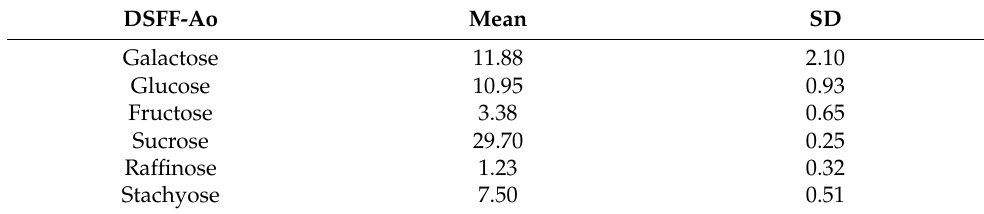
Table 5. DSFF-Ao total sugar